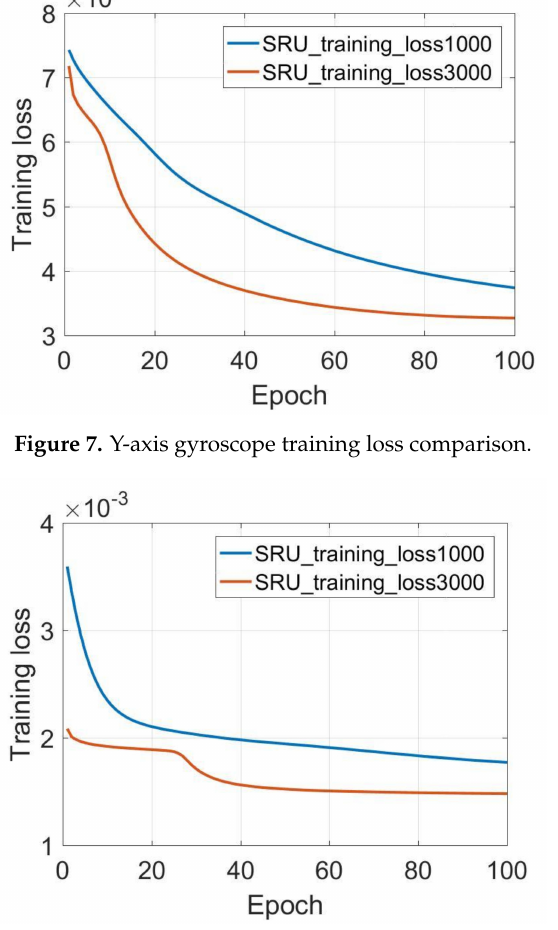
Figure 8. Z-axis gyroscope training loss